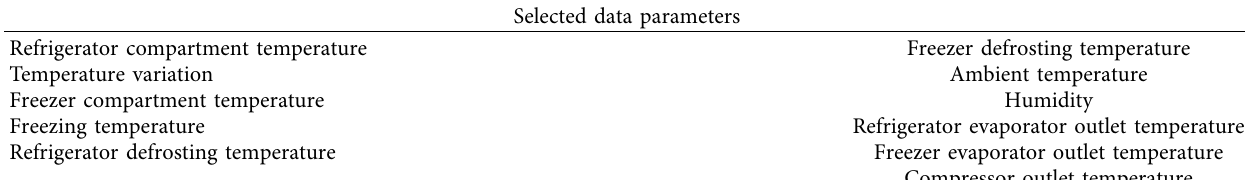
Figure 2: Data preprocessing steps. Table 2: Valid data parameters.